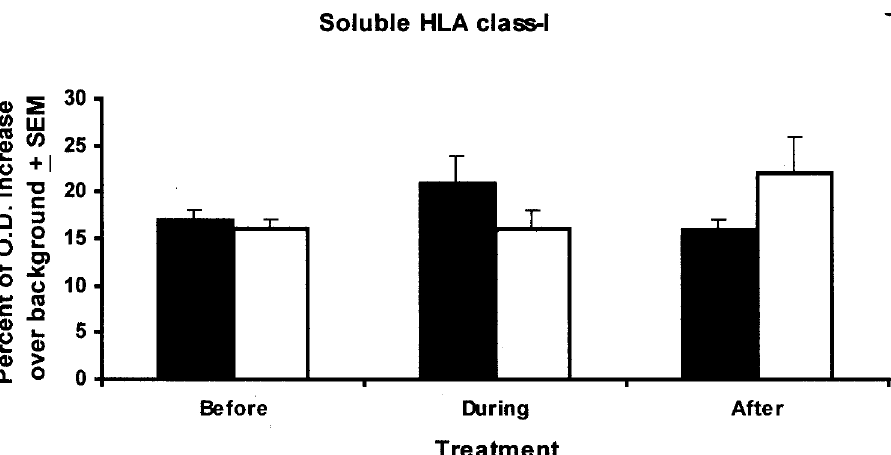
FIG. 2. Serum-soluble human leukocyte antigen (sHLA) class-I levels in women with endometriosis before, during and after treatment with danazol (black bars) or leuprorelin acetate depot (white bars), respectively. For the antibody employed for class I, see Figure 1. The increase obtained in response to danazol during the actual treatment time is of the order of P < 0.01. The results are expressed as the percent of optical density (OD) increase over background levels (±SEM). Background levels (OD values of coating buffer) for the class-I antibody corresponded to 0.110 ± 0.015. The experiment was repeated three times and similar results were obtained.